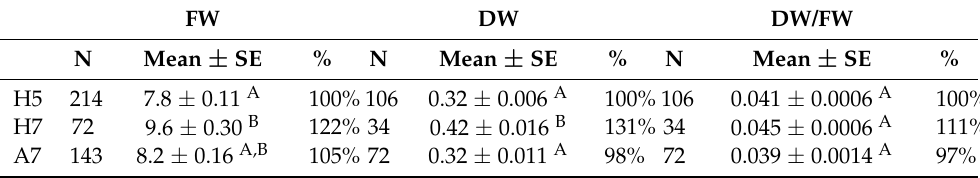
Table 7. Root mean, standard error (SE), and percentage comparison to H5 response for fresh weight (FW, g), dry weight (DW, g), and dry weight to fresh weight ratio (DW/FW, g/g) by trial and treatment with multi-model significance. Differing letters within response variables (columns) denote significance at alpha = 0.05. FW DW DW/FW Mean ± SE